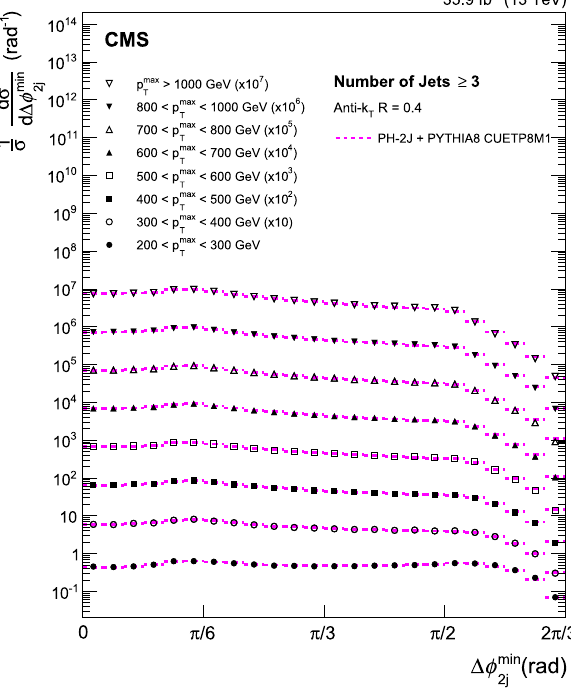
Fig. 10 Normalized inclusive 3-jet cross section differential in Δφ min for eight p max regions, scaled by multiplicative factors for presentation T regions. The solid T purposes. The size of the data symbol includes both statistical and sys- tematic uncertainties. The data points are overlaid with the predictions from the ph- 2j + pythia 8 event